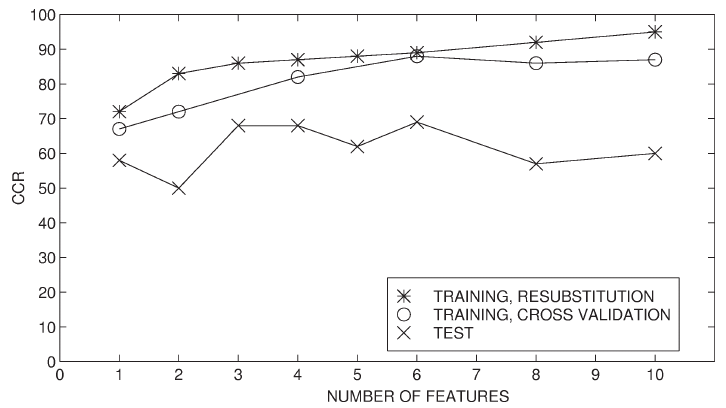
Fig. 2. Estimated classification result as a function of the number of features used in the classification rule selected from the initial feature set of 297 features. The resubstitution estimate from the training data is highly over-optimistic and increases with the number of features used. The cross-validation estimate is also highly over-optimistic and increases with the number of features used, up to a certain point. Testing the classification rules on the independent test data revealed CCRs of about 60%, which are useless results since only few patients with relapse were correctly classified. CCR, correct classification